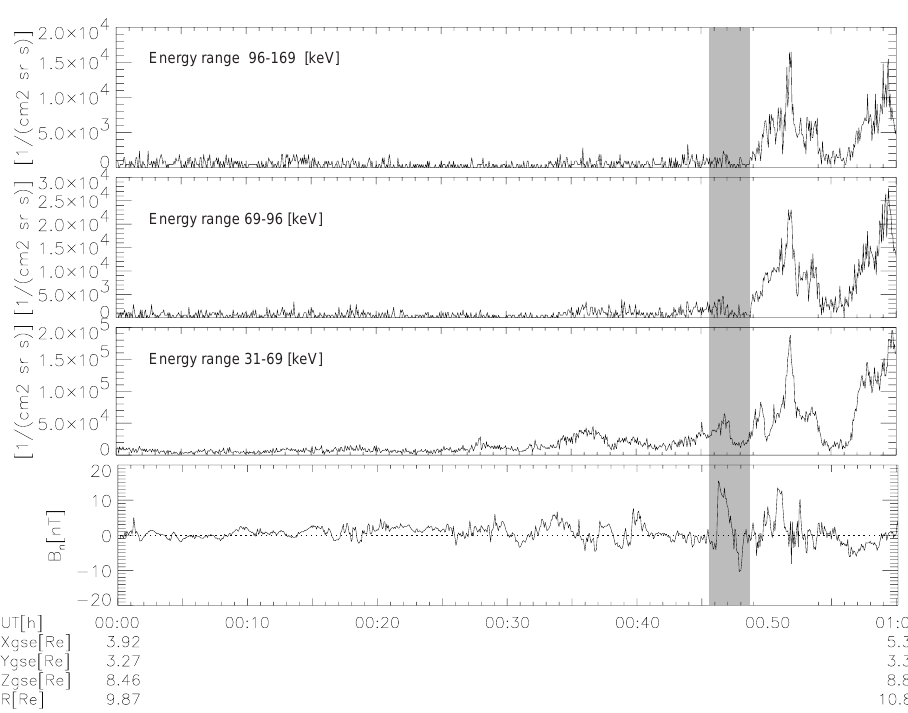
Fig. 8. Time development of the omnidirectional fluxes of the first three energy channels of RAPID and the magnetic field component normal to the magnetopause plane at spacecraft